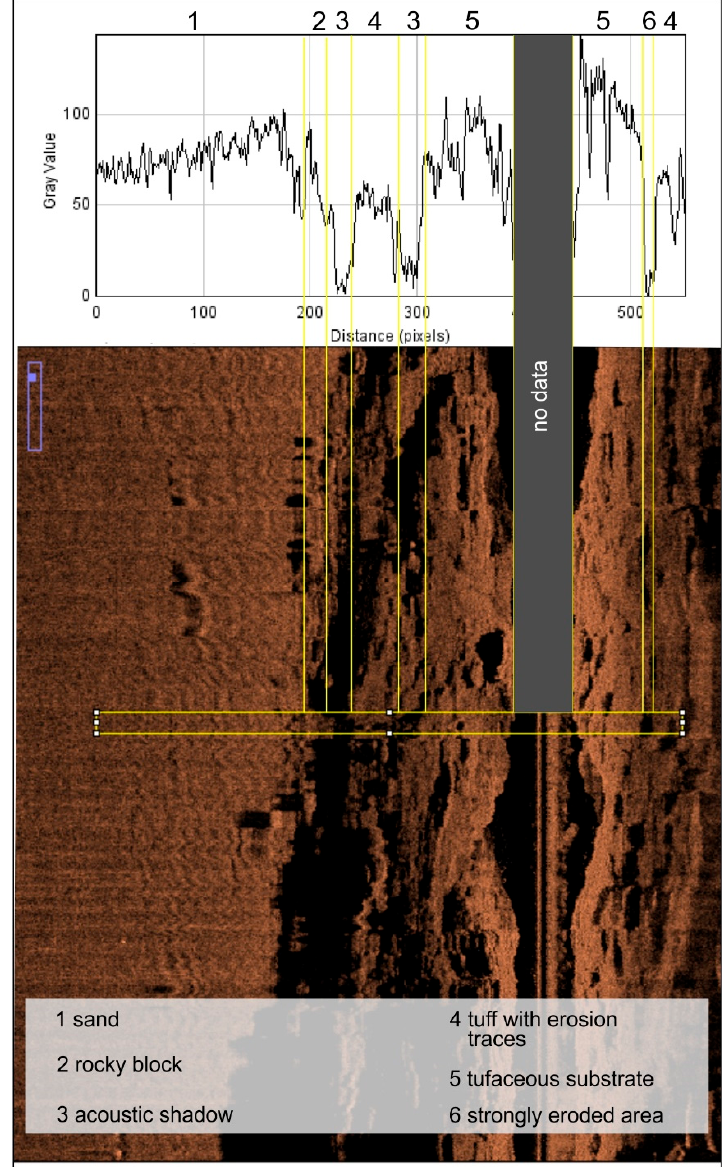
Figure 9. Backscattering signal analysis of a sweep passing through the tufaceous and sandy bottom with the amplitude of the acoustic signal (Y-axis) expressed in greyscale.